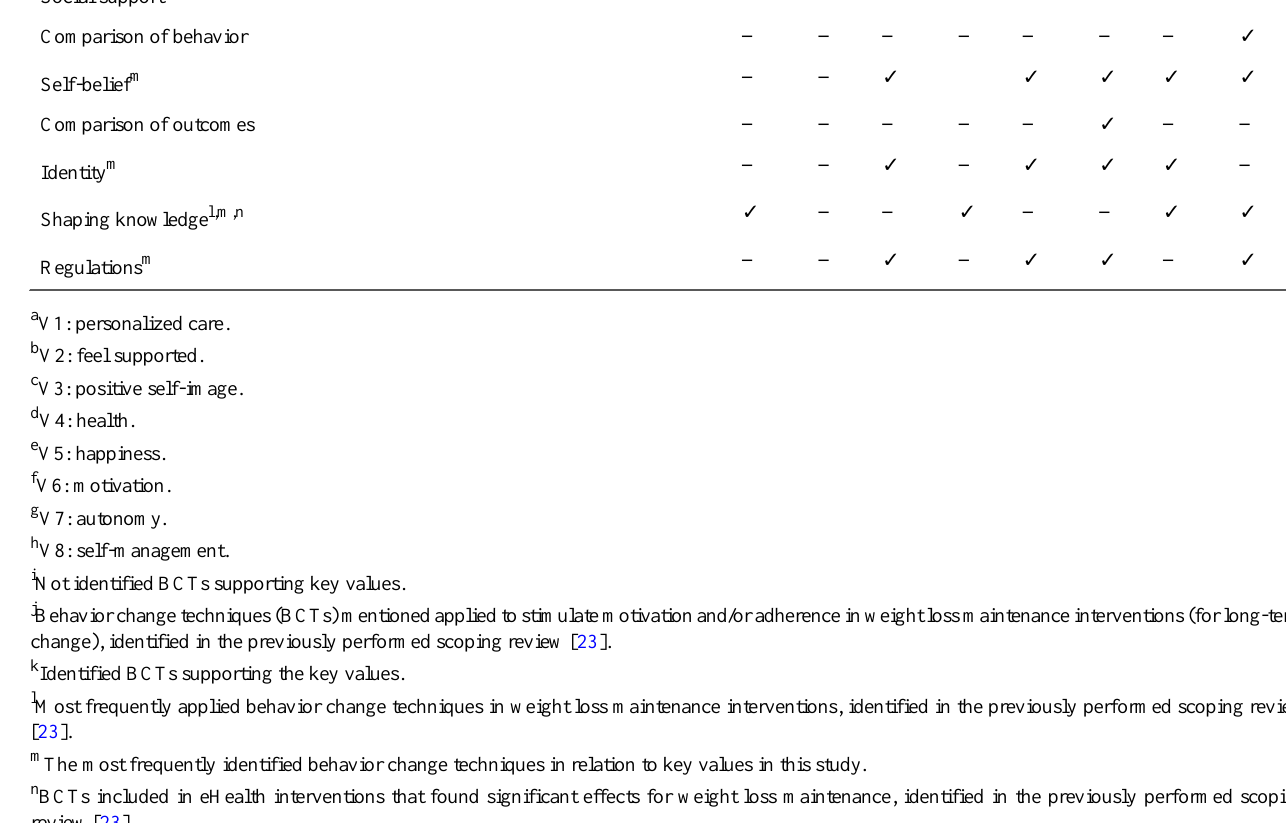
Key valuesBehavior change technique clusters based on behavior change taxonomy by